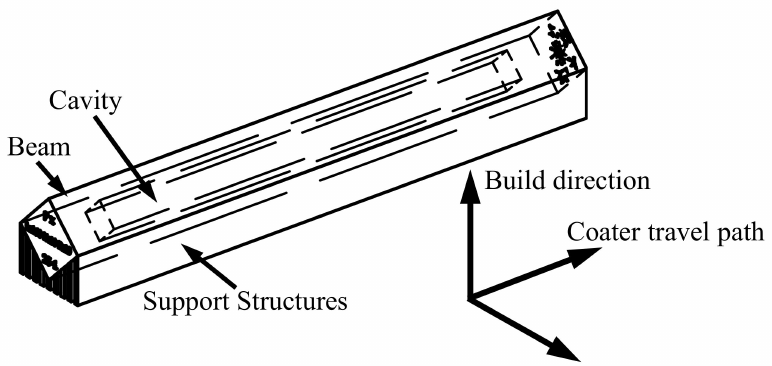
Figure 5. Schematic representation of a particle filled beam on the building